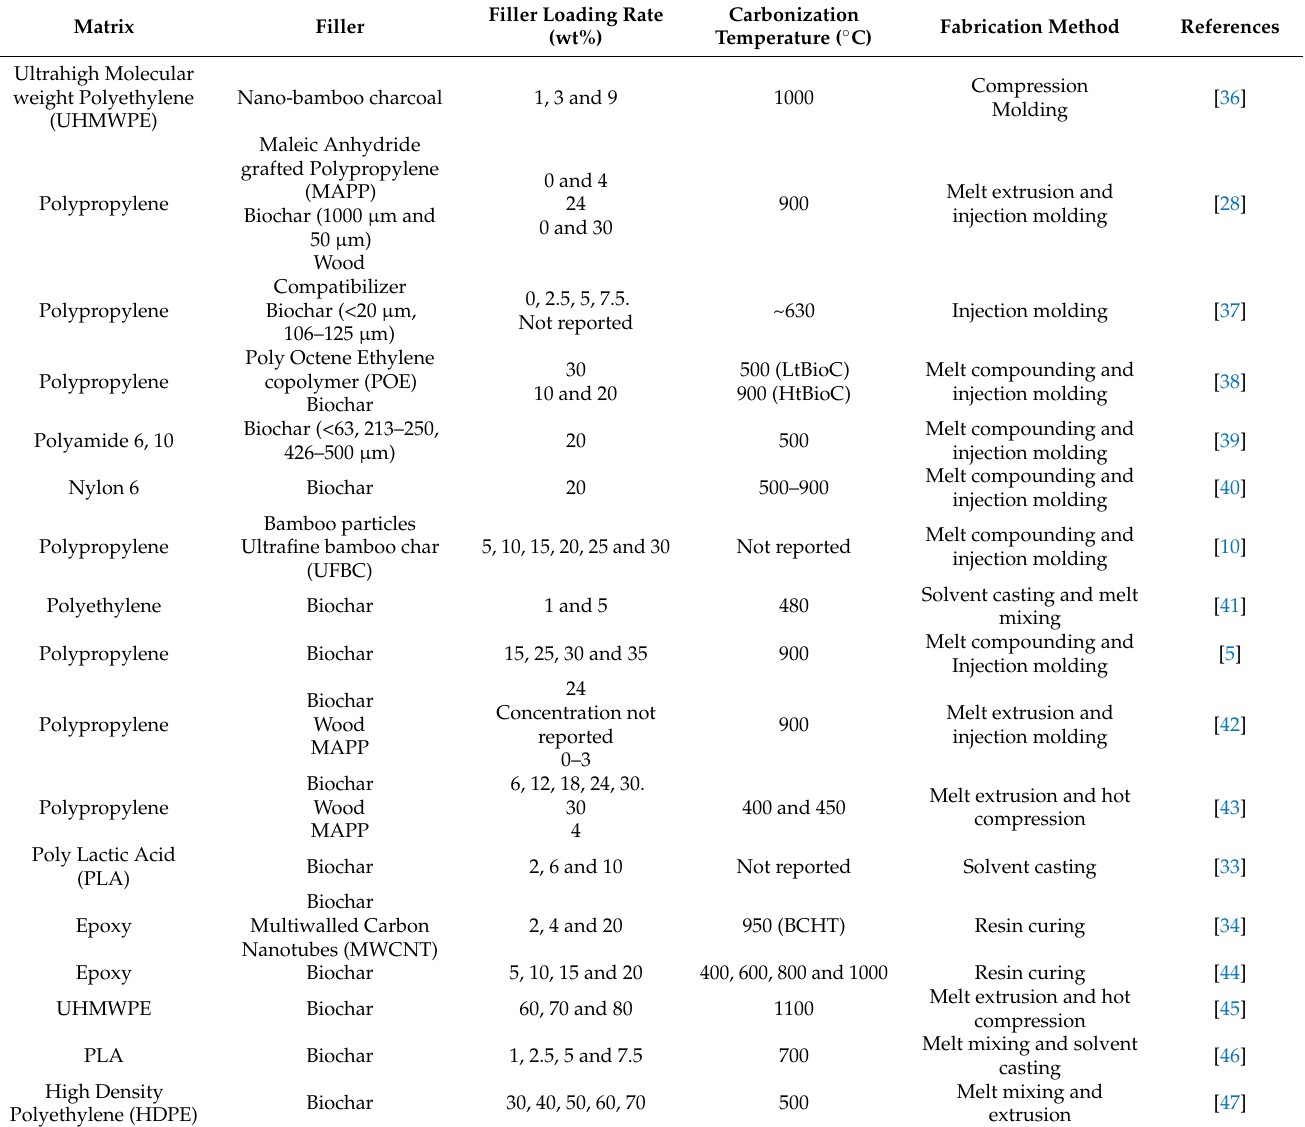
Table 1. Fabrication methods and composition of biochar filled polymer